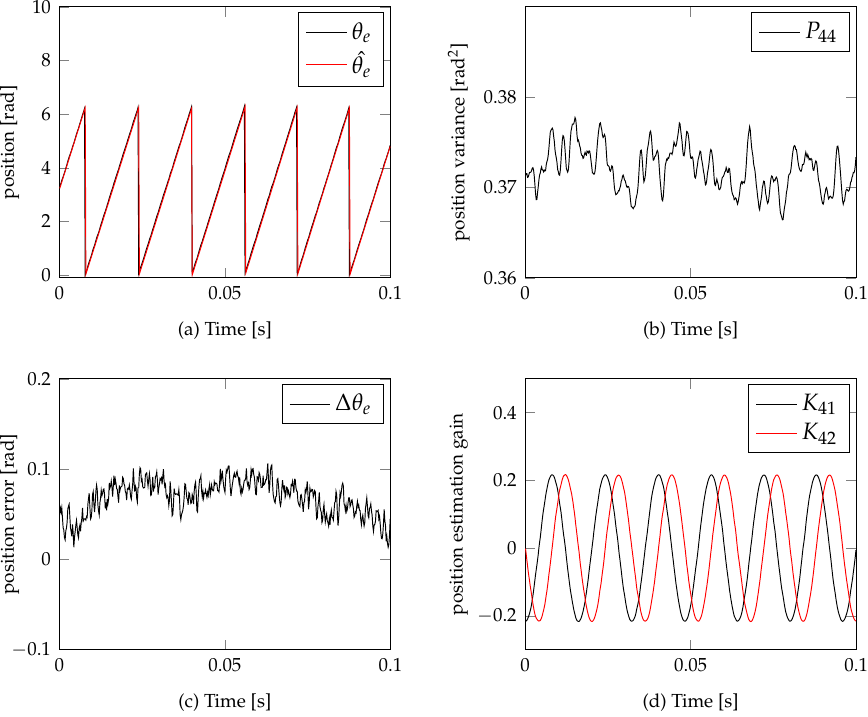
Figure 4. Simulated rotor position estimation performance at f b = 5 kHz f s = 5 kHz and w e = 400 rads. ( a ) real and estimated rotor positions, ( b ) estimated position error, ( c ) estimated position variance, ( d ) position estimation Kalman